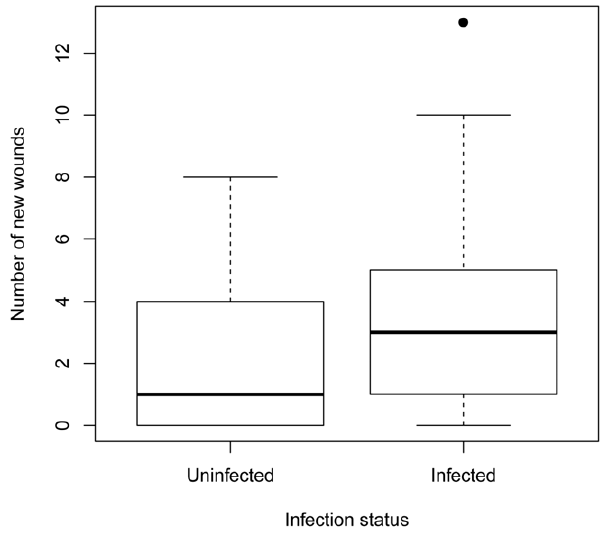
Figure 4. Median number of new wounds per individual deermouse by infection status. Thick horizontal line is the median; top and bottom of boxes represent the 25 and 75 percentile, respectively; horizontal lines at ends of dashed lines represent the minimum and maximum values, excluding one outlier (black dot). The infected category includes all donor and TE deermice from all 4 experiments. The uninfected category includes all susceptible deermice that never seroconverted. Each deermouse is represented only once in the analyses.